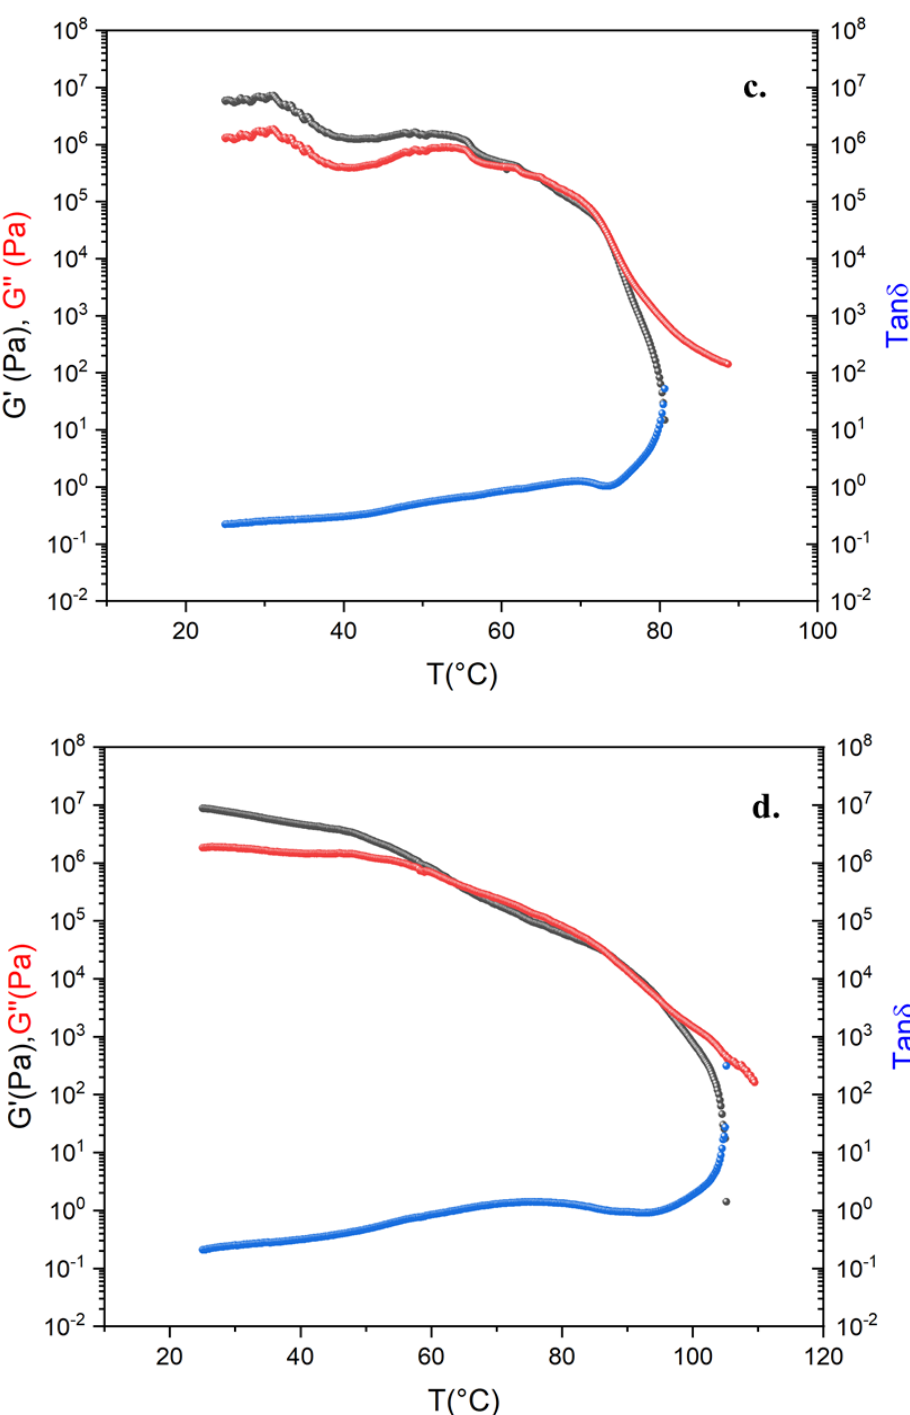
Figure 2. Dynamic Temperature Ramp Test (DTRT) of ( a ) blend 26-1, ( b ) blend 29-1, ( c ) blend 27-1, ( d ) blend 32V1.